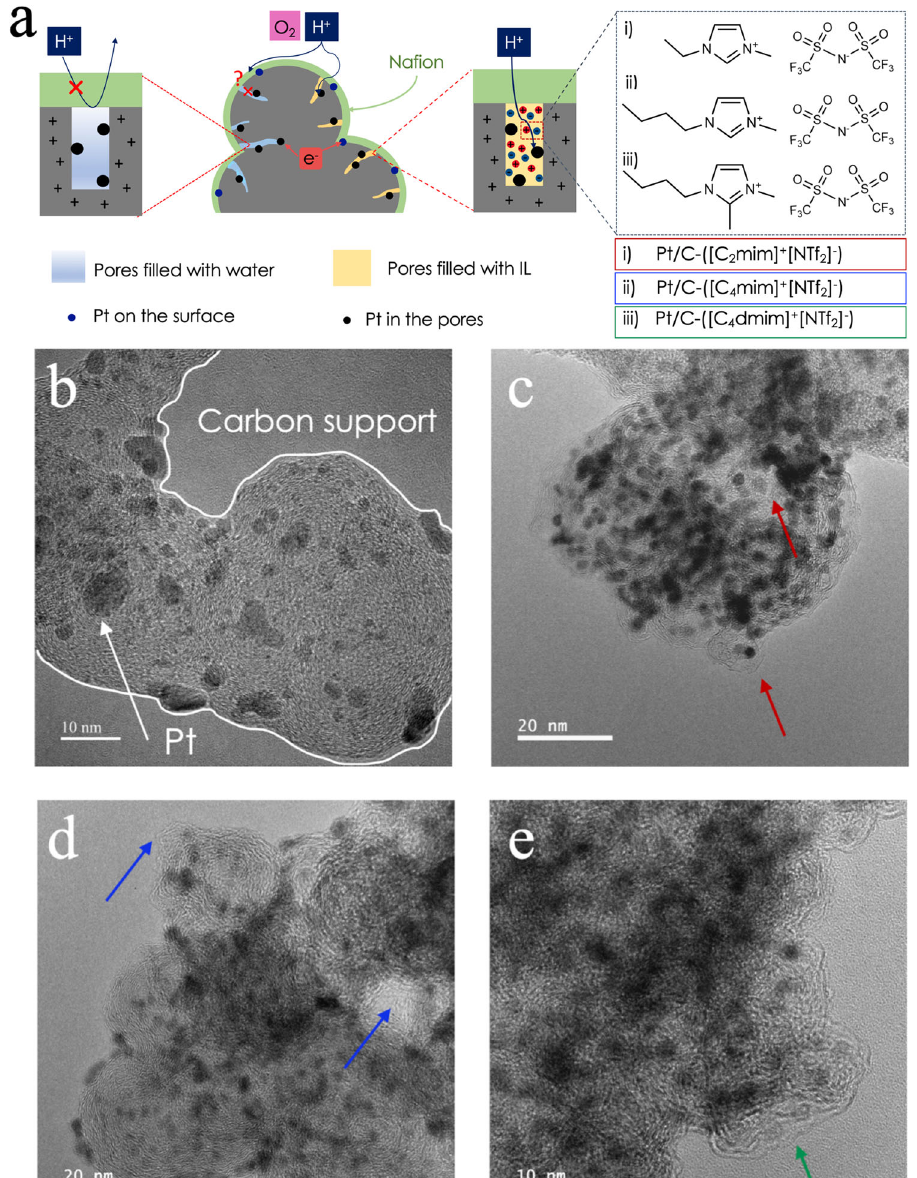
Fig.1|SchematicdrawingofcatalystlayerinterfaceandTEMimagesofpristine andmodi fi edcatalystpowders.a